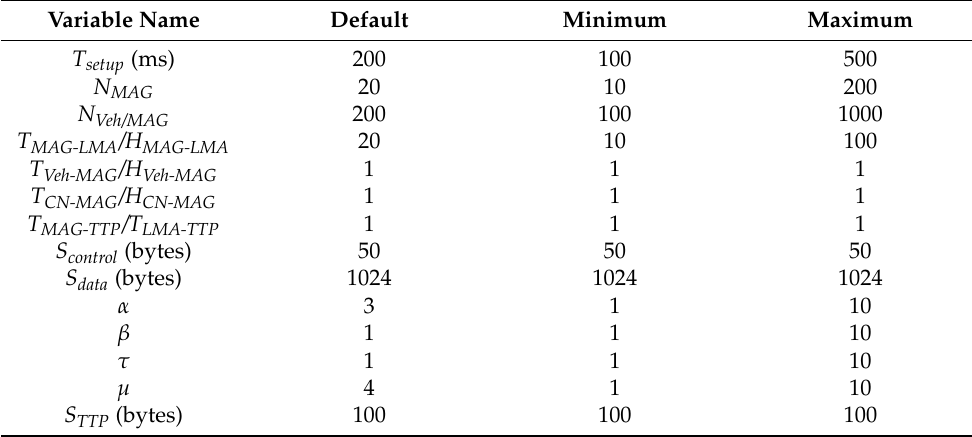
Table 2. Values of parameters used in cost analysis of VANET in